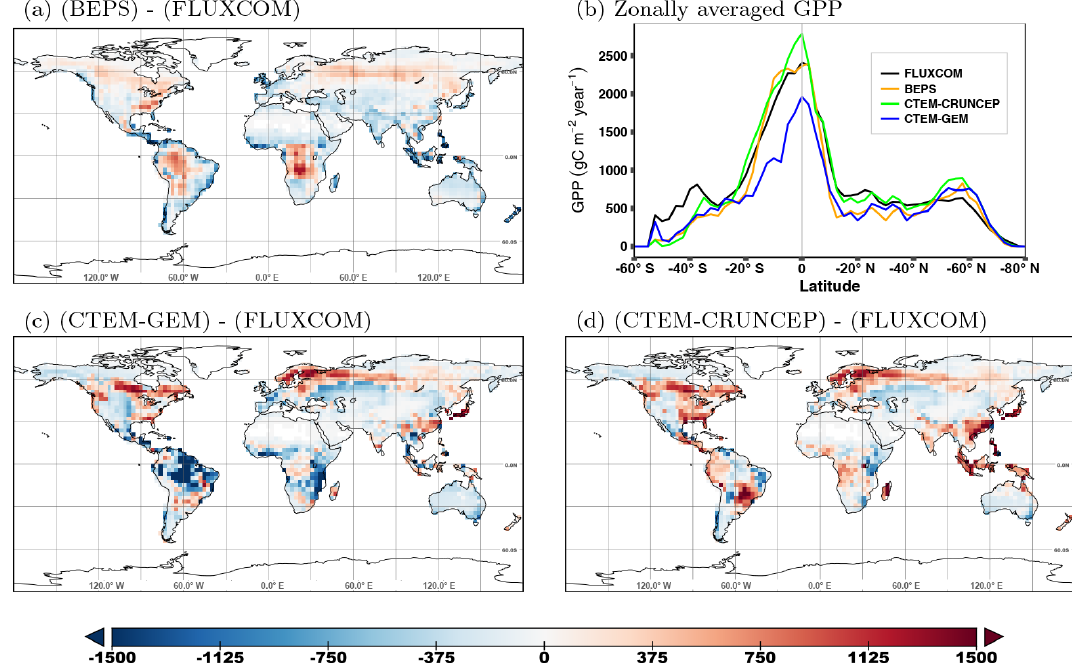
Figure 7. The annual spatial difference of GPP (gCm − 2 yr − 1 ) for CTEM-GEM, CTEM-CRUNCEP, and BEPS against the observation- based GPP estimates from FLUXCOM (averaged over the period 2009–2010). The zonal distributions of GPP from all datasets are shown in panel (b)